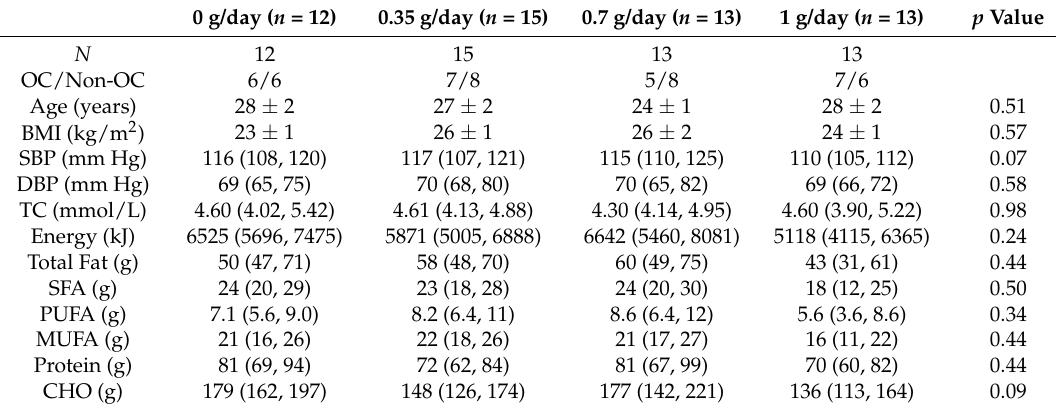
Table 1. Characteristics (values mean ± standard error of the mean (SEM) or median (25th percentile, 75th percentile); n = 53) and daily dietary energy (kJ/day) and macronutrient intakes (g/day) (values median (25th percentile, 75th percentile); n = 45) of subjects in double-blind placebo-controlled trial at